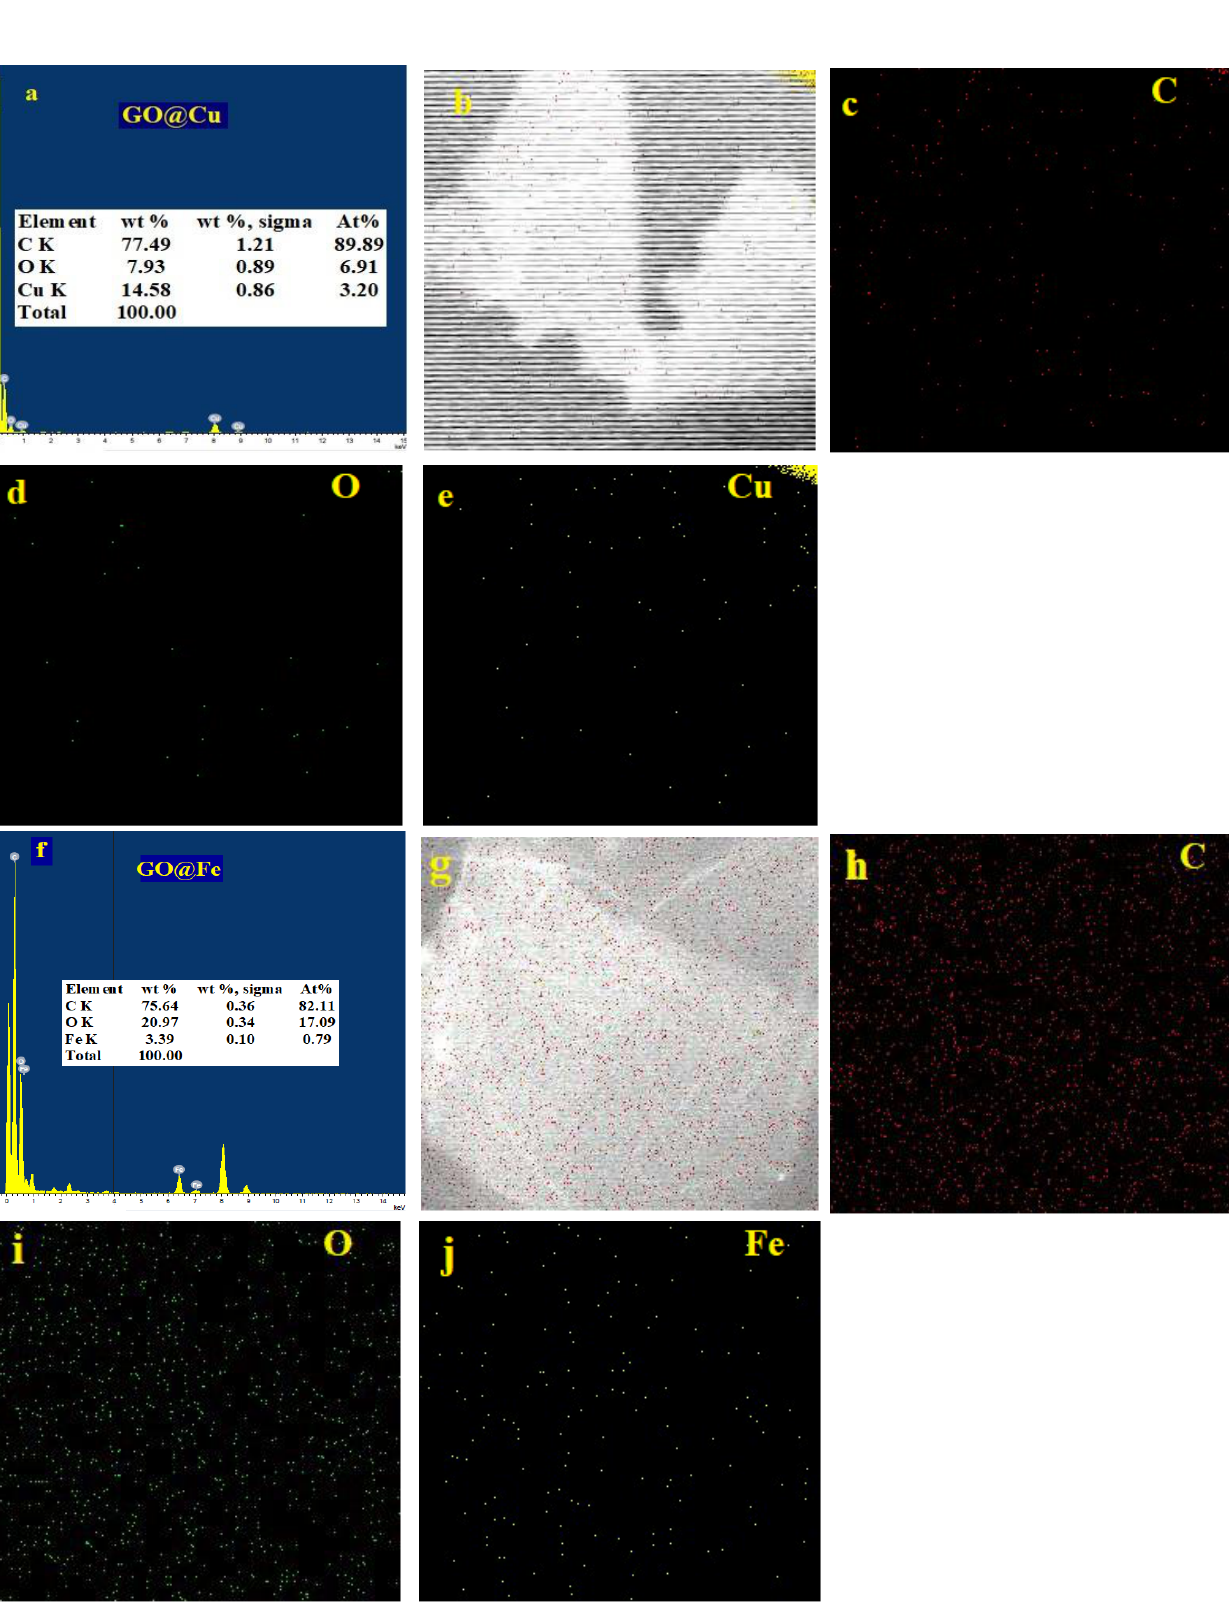
Figure 2. EDX and mapping analysis of GO @ Cu ( a – e ) and GO @ Fe ( f – j ).